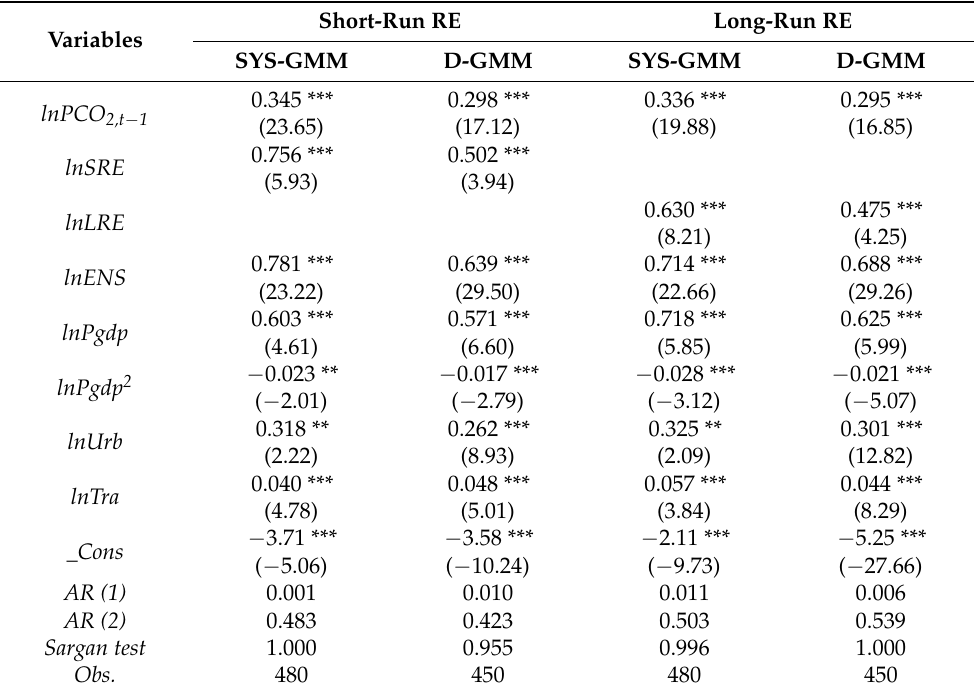
Table 6. Robustness test results using an alternative variable.